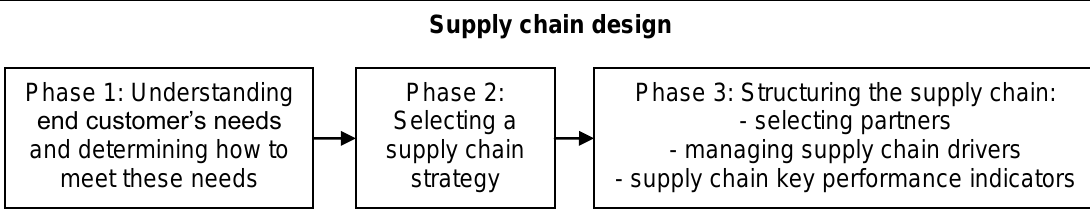
Figure 1: The three phases of supply chain